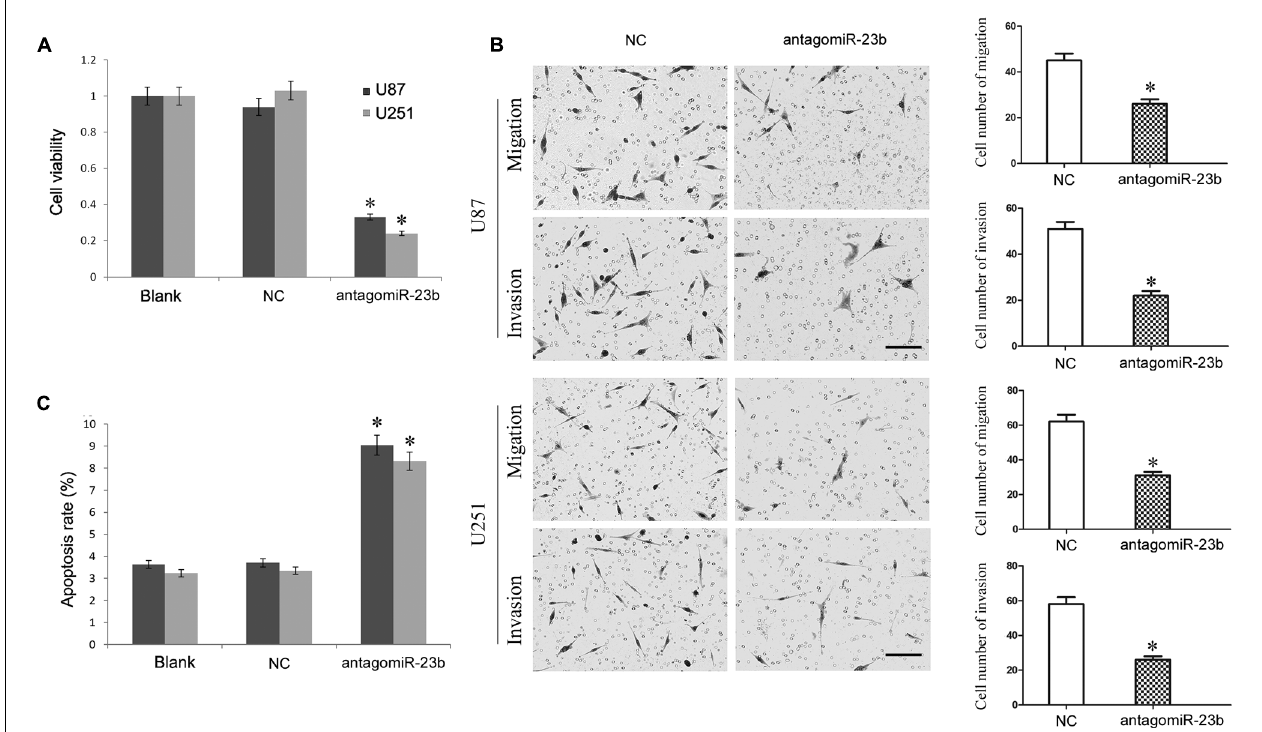
FIGURE 5 | (A,B) Mir-23b down-regulation inhibited cell viability and advanced apoptosis of U251 and U87 cells. (C) Mir-23b down-regulation disrupted the migration and invasion of U251 and U87 cells, Scale bars represent 100 µ m. ∗ P < 0.05 vs. Blank and NC group.